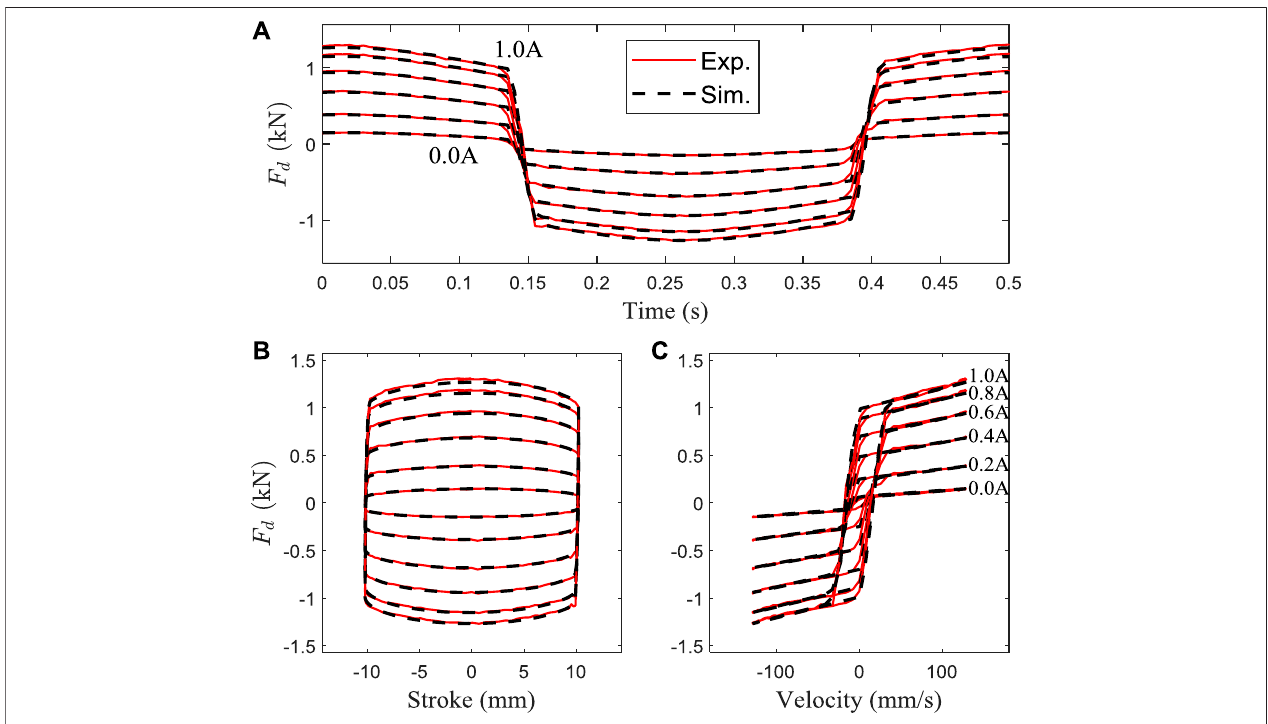
FIGURE 3 | Comparison between the predicted and experimental data (normalized Bouc-Wen model): (A) the damping force vs. time; (B) the damping force vs. stroke; (C) the damping force vs. velocity.